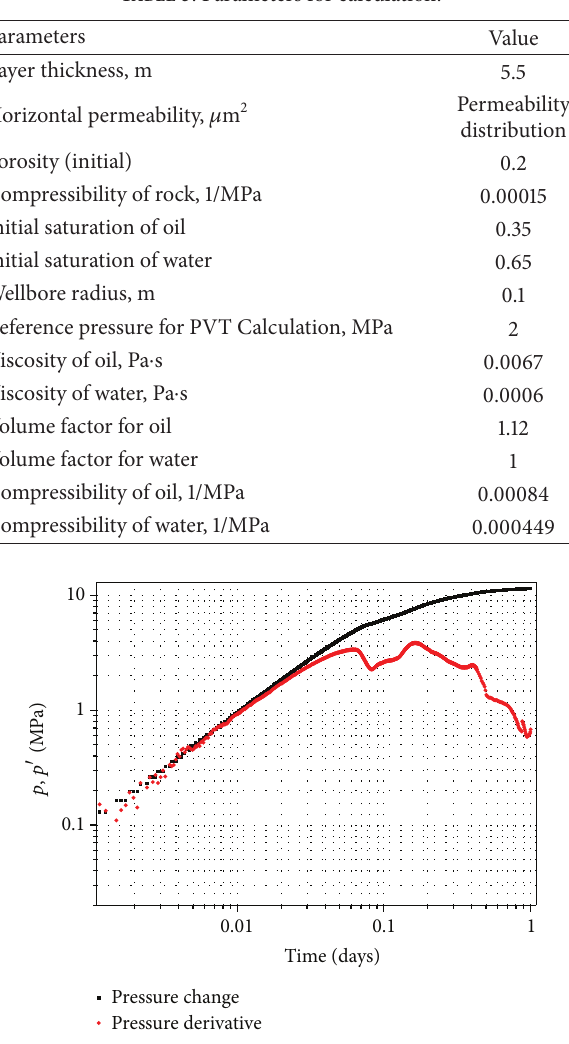
Figure 13: Pressure change and pressure derivative history match for